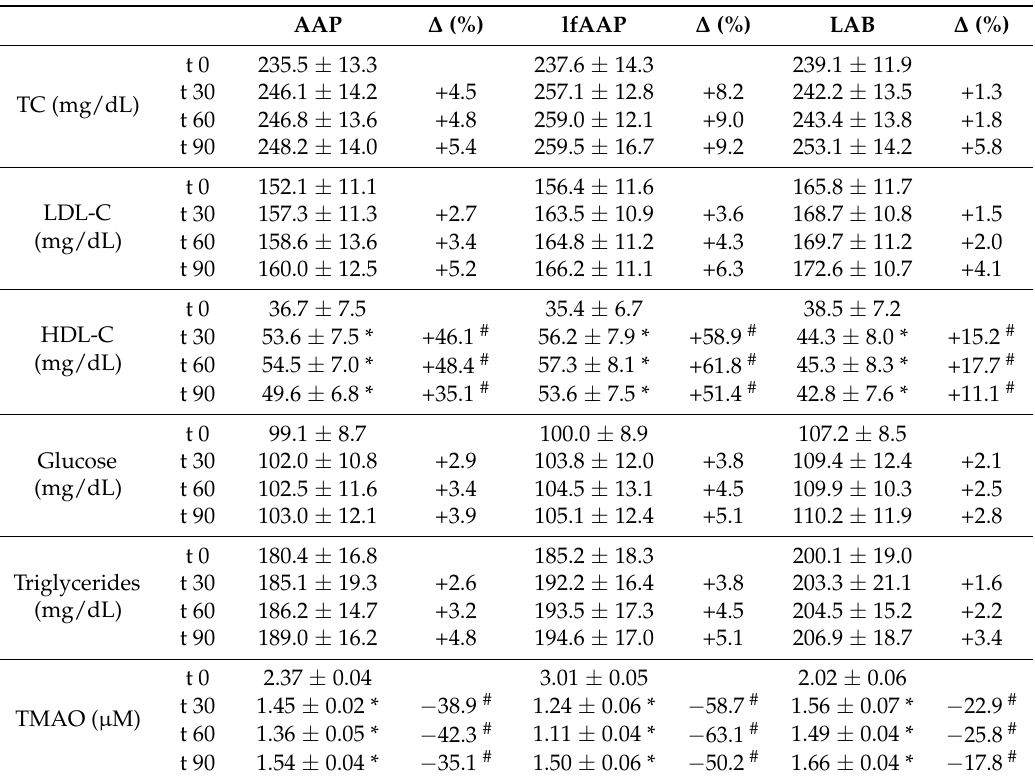
Table 3. Effects of Annurca apple puree (AAP) and its lactofermented version (lfAAP) on plasma cholesterol, glucose, triglyceride, and TMAO levels. AAP ∆ (%) lfAAP ∆ (%)